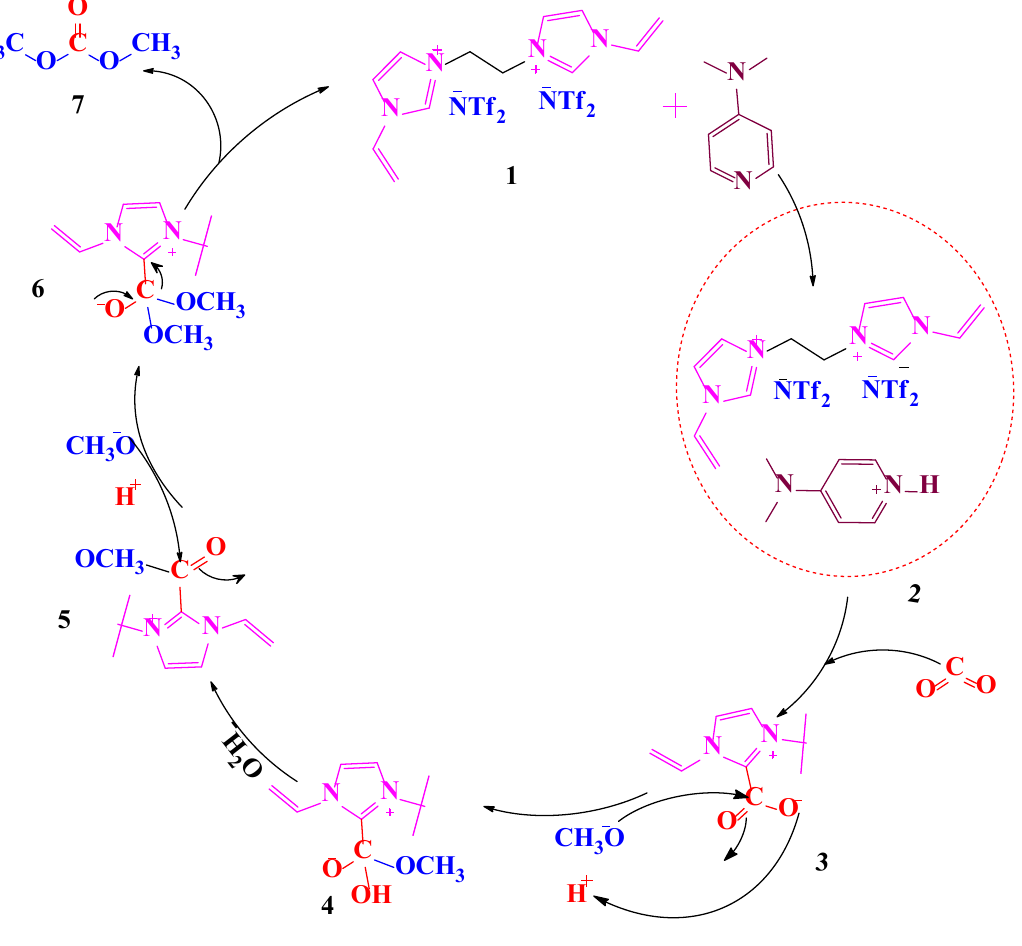
Scheme 4: Proposed mechanism for DMC synthesis catalyzed by vinyl-imidazolium